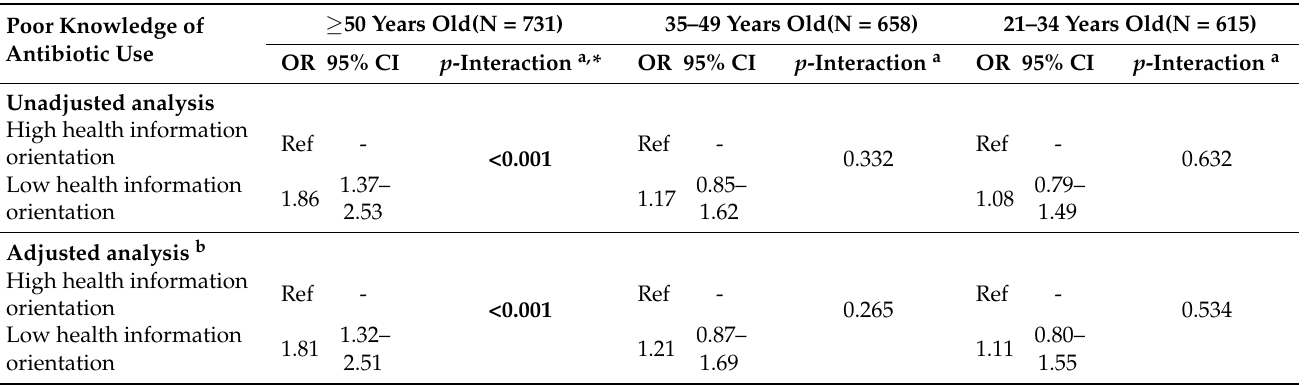
Table 4. Association between poor knowledge of antibiotic use and health information orientation, according to age group (N =